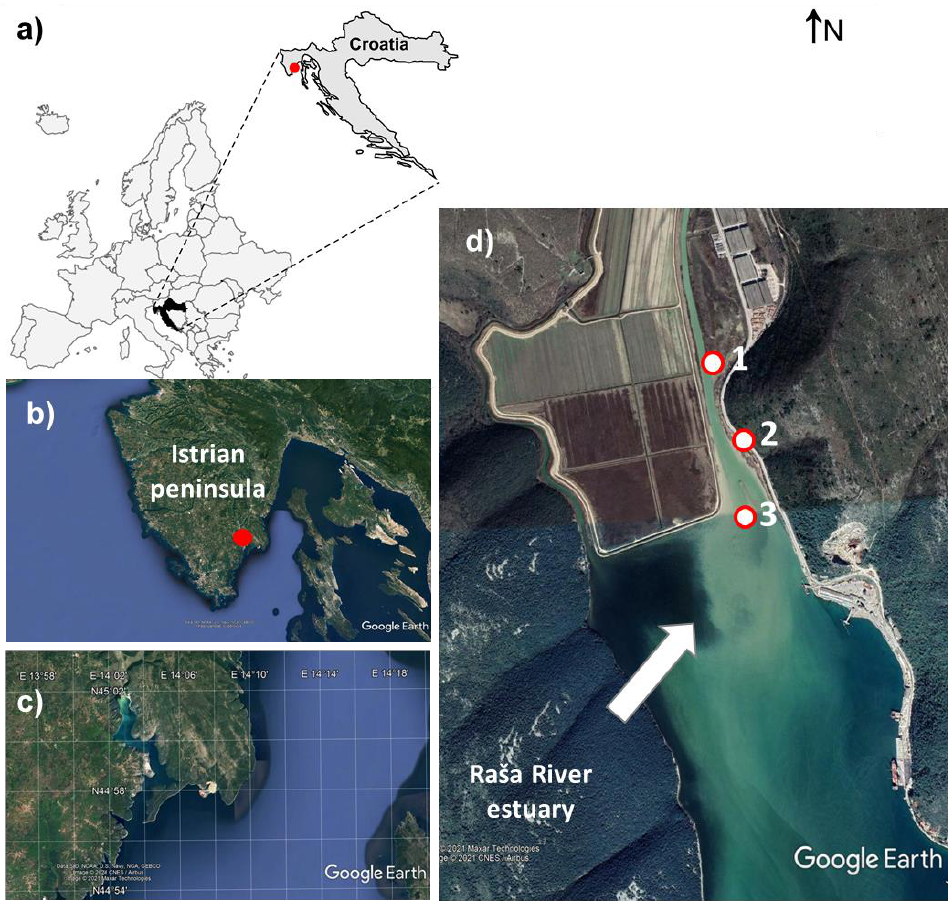
Figure 4. ( a ) Map of the study area, its geographical position; ( b ) Sampling area; ( c ) A more detailed view of the research area; ( d ) Studied estuary, with indicated sampling sites.